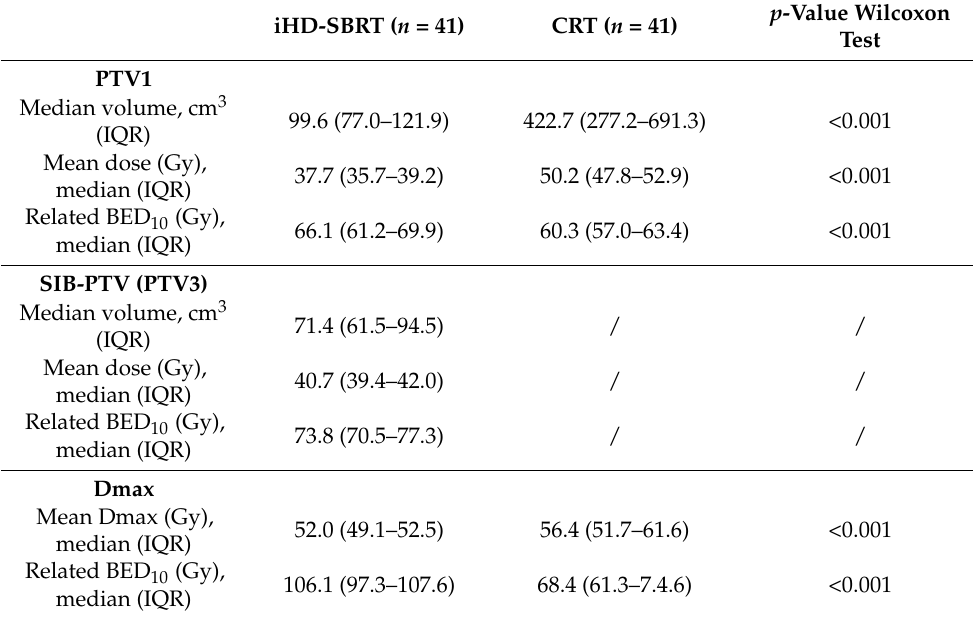
Table 2. Treatment plan analysis for the PTVs and related BED 10